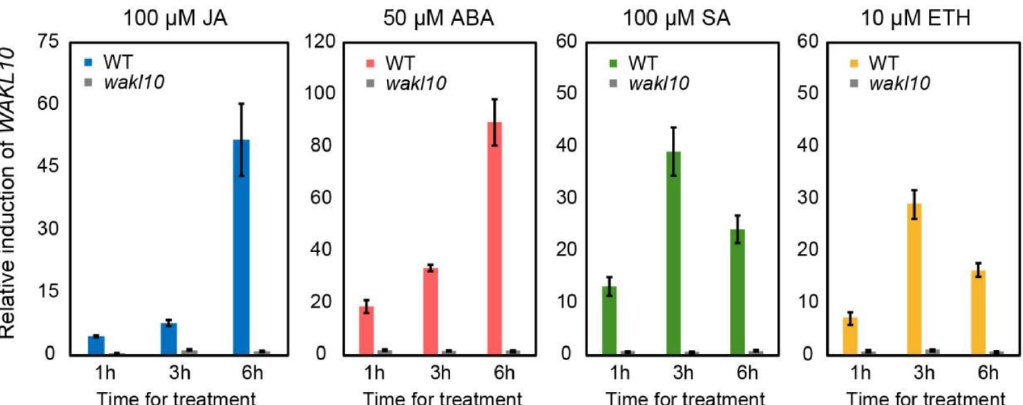
Figure 8. The expression pattern of AtWAKL10 in response to various hormones. Ten-day-old seedlings of wild type and atwakl10 mutant were water cultured on 1/2 MS medium supplemented with 100 µ M JA, 50 µ M ABA, 100 µ M SA, and 10 µ M ETH for 6 h, respectively. Samples were collected at different time points as indicated. For each genotype, the relative induction in abundance of AtWAKL10 under each treatment condition was calculated relative to the mock-treated expression levels after being normalized against ACT2